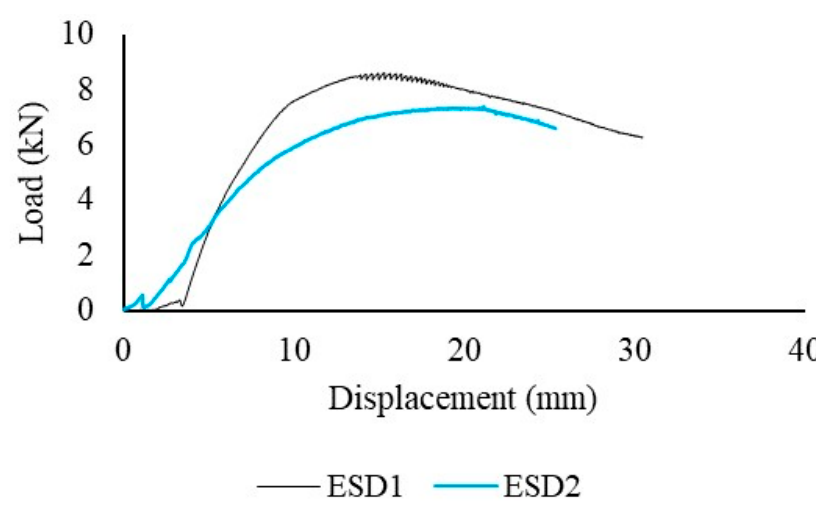
Figure 18. Load vs. displacement for end support deck tests.